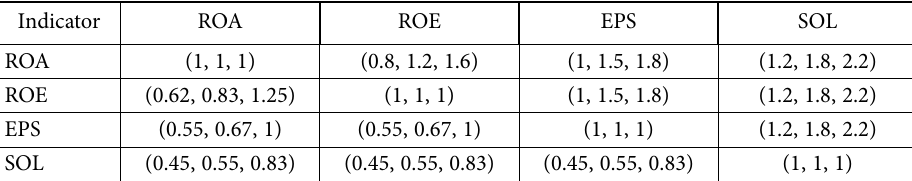
Table 3. Fuzzy pair-wise comparison matrix for the sub-criteria of the AFP (accounting based financial performance) main-criteria Indicator ROA